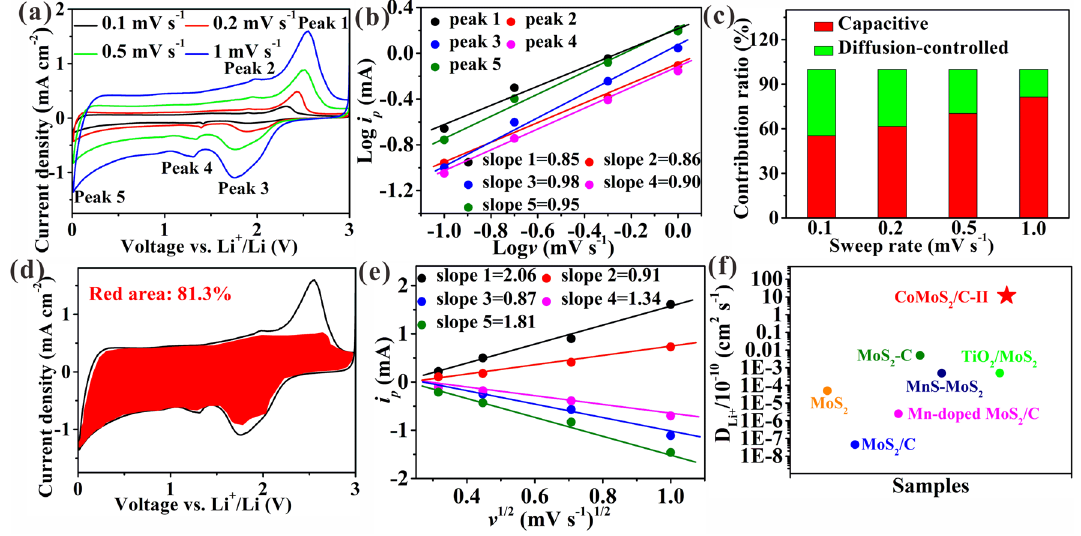
Fig. 4 Kinetic analysis of CoMoS 2 /C-II. a CV curves. b Log i p vs Log v . c Pseudocapacitive contribution percentages. d Specific capacitive con- tribution curve. e i p vs v 1/2 . f Comparison of D Li